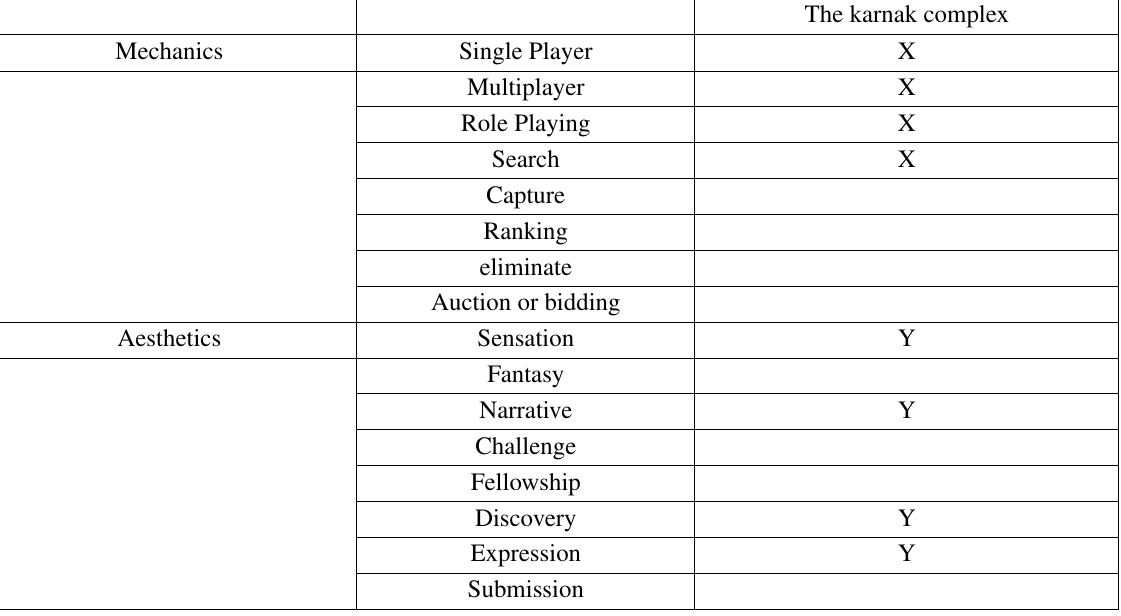
Table 6. Assigning game mechanics and aesthetics to the Karnak temple